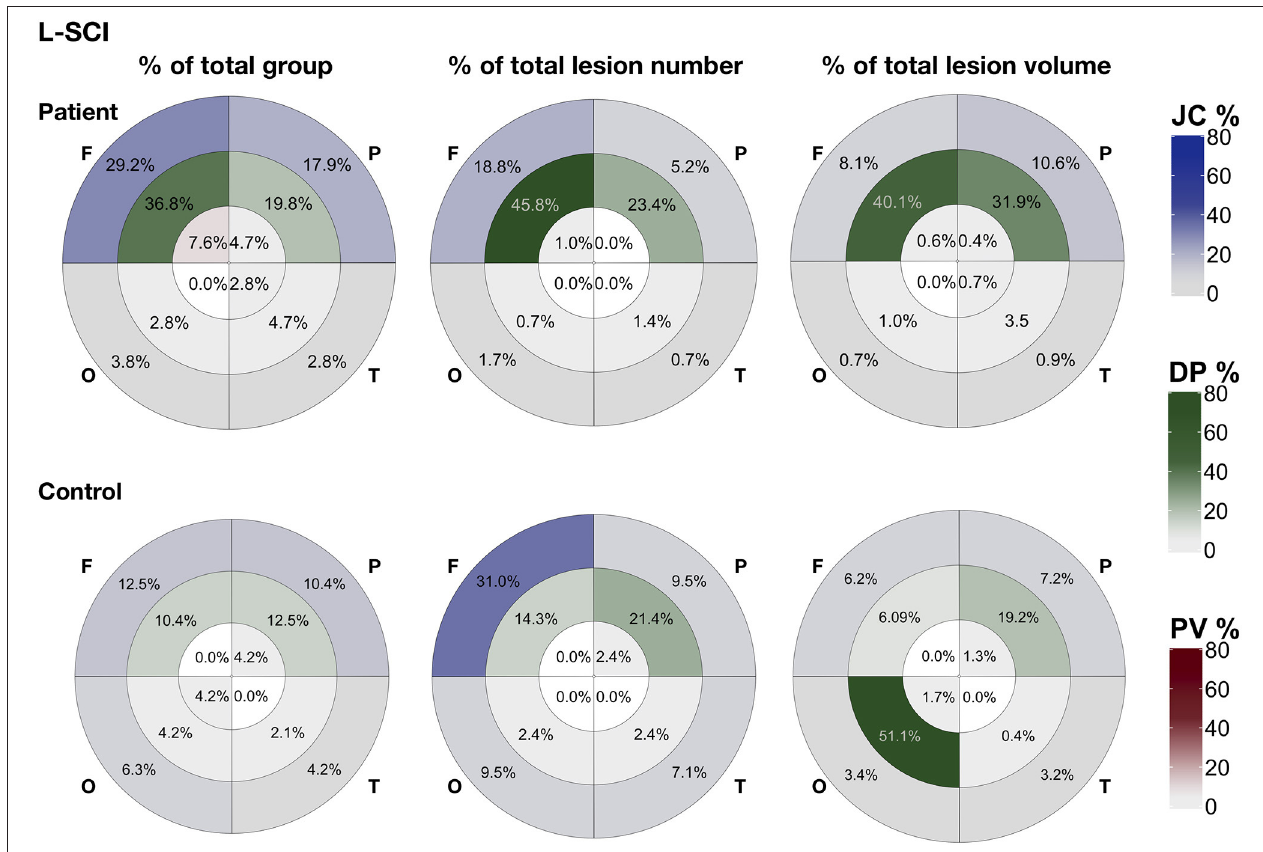
FIGURE 7 | Lesion distribution for liberally-defined SCI. Showing the distribution of lesions using bullseye plots, where sectors represent the four lobes (F, frontal; P, parietal; O, occipital; T, temporal) and rings represent the three regions; periventricular (PV; interior ring; red), deep (DP; middle ring; green), and juxta-cortical (JC; exterior ring; blue), yielding 12 regional lobar zones. Distribution is represented using three different metrics for patients (top row) and controls (bottom row): (1) the proportion of the total group with lesion voxels in particular zone (% of total group), (2) the proportion of the total group lesion number classed as belonging to regional-lobar zone (middle - % of total lesion number), and (3) the proportion of the total group lesion voxels present in a particular regional-lobar zone (right - % of total lesion